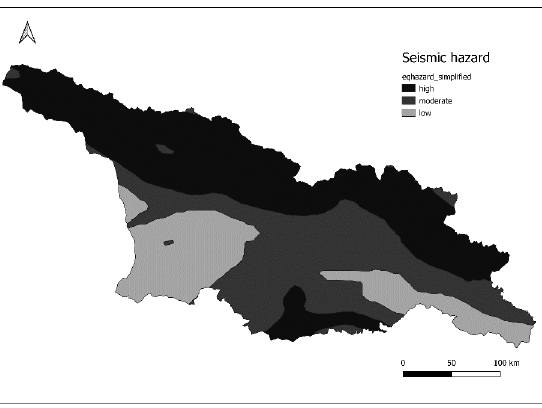
Figure 2. Seismic hazard map (CENN, 2018)